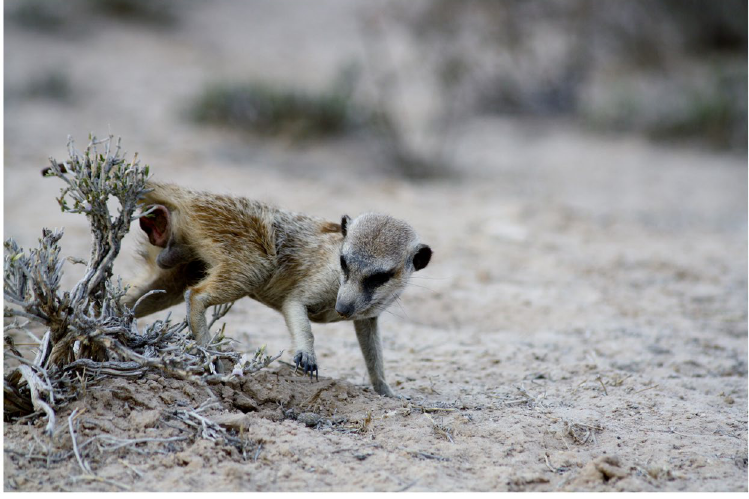
Figure 1. Photograph of a male meerkat everting his anal pouch during scent marking. (Photo courtesy of Lydia K.